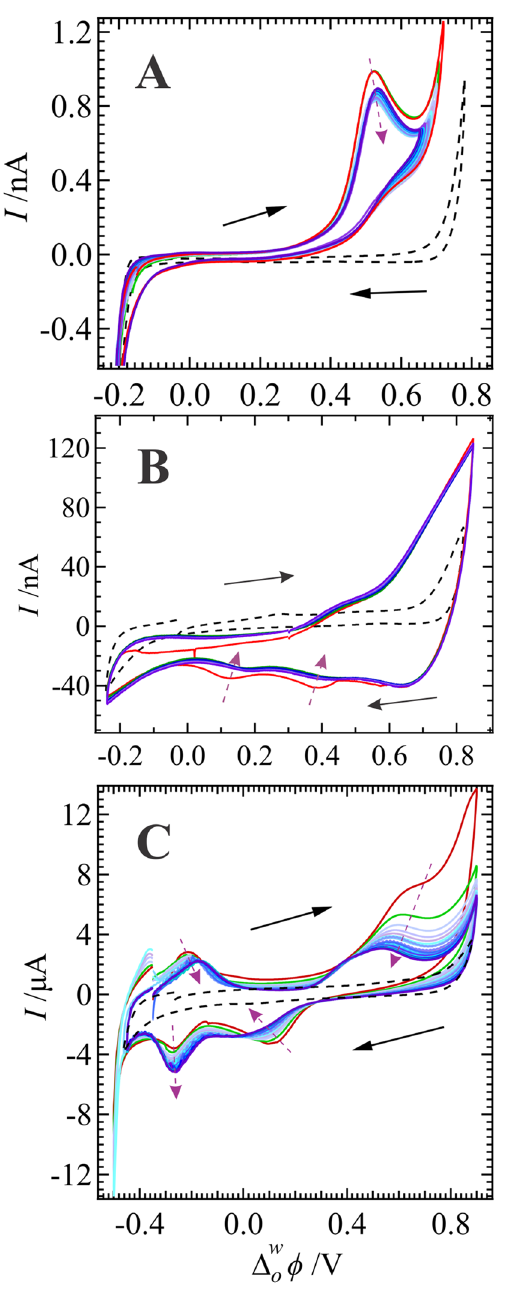
Figure 2. i-V curves recorded at 0.020 V s –1 using Cell 1 ( A , B ) and 2 ( C ), or the 25 µm, 1.16 mm, and 10 mm ITIES, respectively, with [TT] = 20 mM and [CuSO 4 ] = 5 mM, while the black, dashed traces show the system without TT added, i.e. , blank curves. DCE was used as the organic solvent in all cases. Cyclic voltammograms have been scanned consecutively 25 times and overlaid such that the red and dark purple traces are the first and last scans, respectively; dashed, purple arrows indicate the evolution of the current signals with successive scans. Black arrows indicate scan